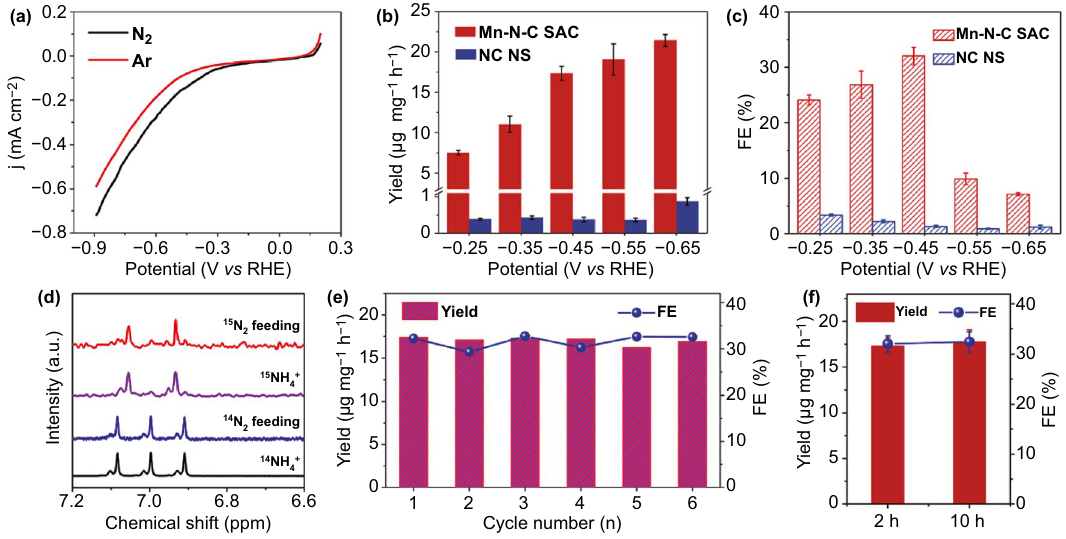
Fig. 3 a LSV curves of Mn–N–C SAC obtained at a scan rate of 10 mV s −1 under N 2 and Ar environment. b NH 3 yields and c FEs of Mn–N–C SAC and NC NS at various potentials. d 1 H‑NMR spectra of the electrolytes using 15/14 N 2 as feedstock gases. e NH 3 yields and FEs of Mn–N–C SAC at − 0.45 V after independently repetitive electrocatalysis experiments. f FEs and yields for the 10‑h durability test at ‑0.45